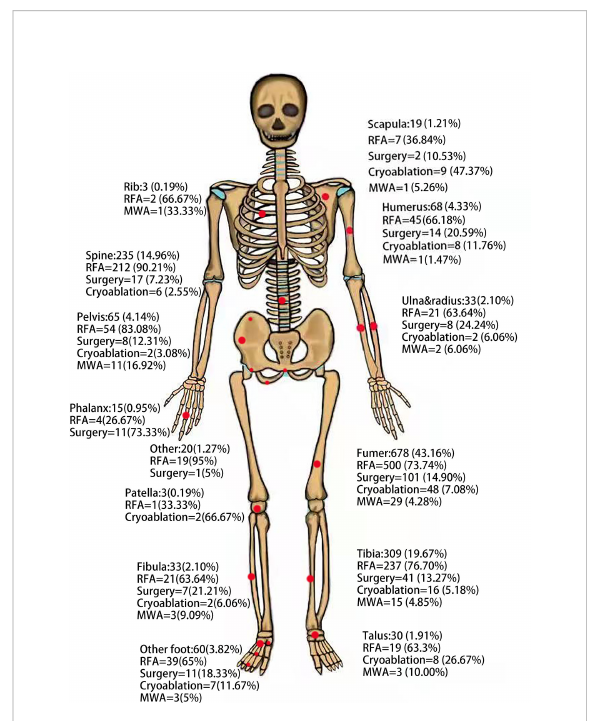
FIGURE 2 Anatomic distribution of osteoid osteomas in the patient cohort based on